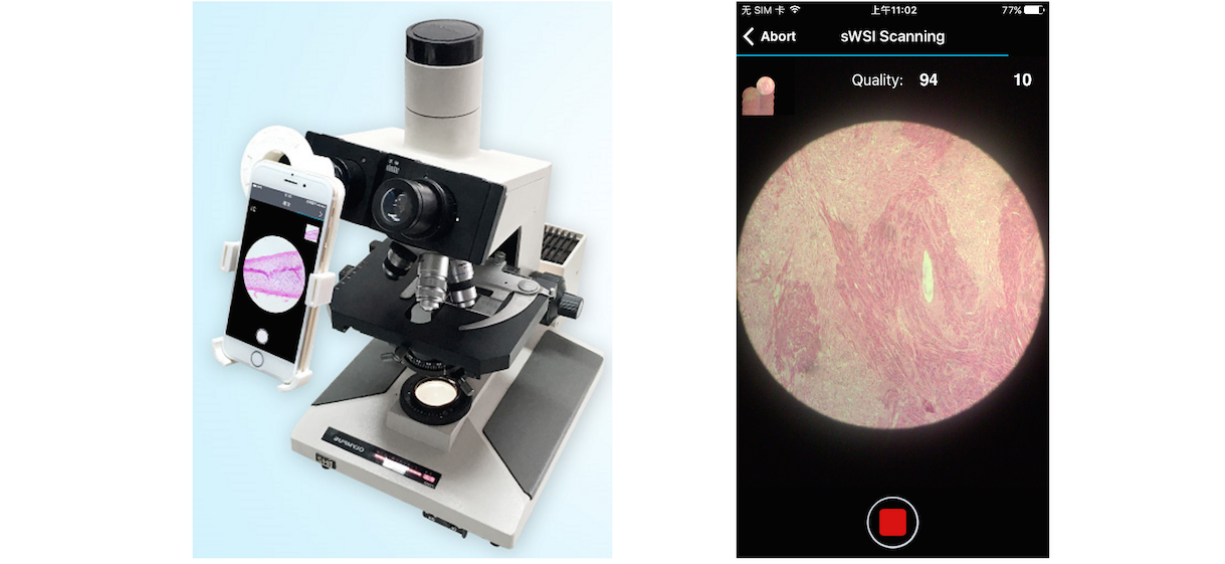
Figure 2. Typical hardware setup (left) and user interface